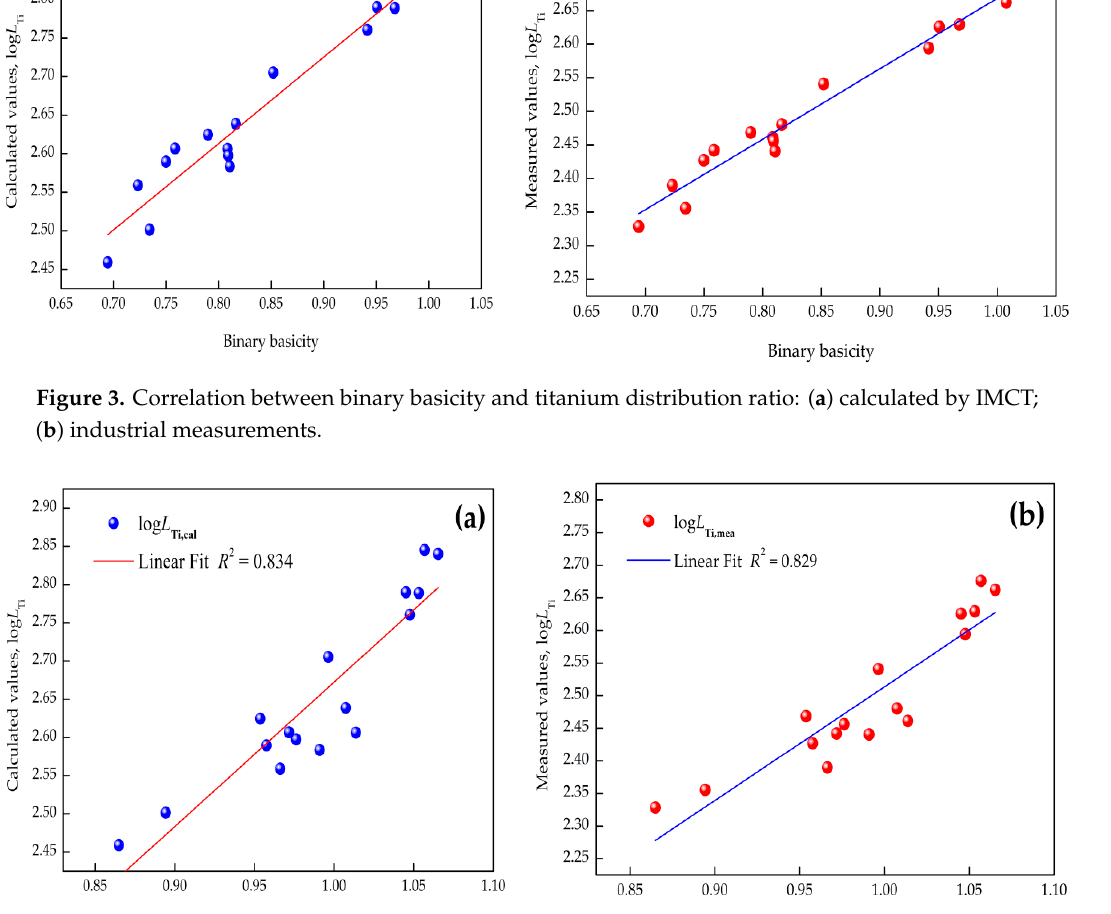
Figure 5. Correlation between optical basicity and titanium distribution ratio: ( a ) calculated by IMCT; ( b ) industrial measurements. 3.3. Contribution Ratio of the Respective Titanium Distribution Ratio Based on the IMCT In addition to the total titanium distribution ratio of LF refining slags predicted by the established IMCT model, the respective titanium distribution ratio in the present slag system also can be determined. In order to expound the titanium distribution behavior in the LF process, the respective titanium distribution ratios of TiO (cid:2870) , CaO ∙ TiO (cid:2870) , MgO ∙ TiO (cid:2870) , FeO ∙ TiO (cid:2870) , and MnO ∙ TiO (cid:2870) in the slags can be acquired by the built IMCT model, respectively, and correlations between the quantitative titanium distribution ratio 𝐿 (cid:2904)(cid:2919),(cid:3036),(cid:2913)(cid:2911)(cid:2922) of the five structural units and the 𝐿 (cid:2904)(cid:2919),(cid:2913)(cid:2911)(cid:2922) is described in Figure 6. It is evident that 𝐿 (cid:2904)(cid:2919),(cid:3036),(cid:2913)(cid:2911)(cid:2922) had a nice linear relationship with 𝐿 (cid:2904)(cid:2919),(cid:2913)(cid:2911)(cid:2922) , and the respective contribution rates of the structural units containing TiO 2 to total titanium distribution ratios in the slags can be defined by the fitted line gradient.